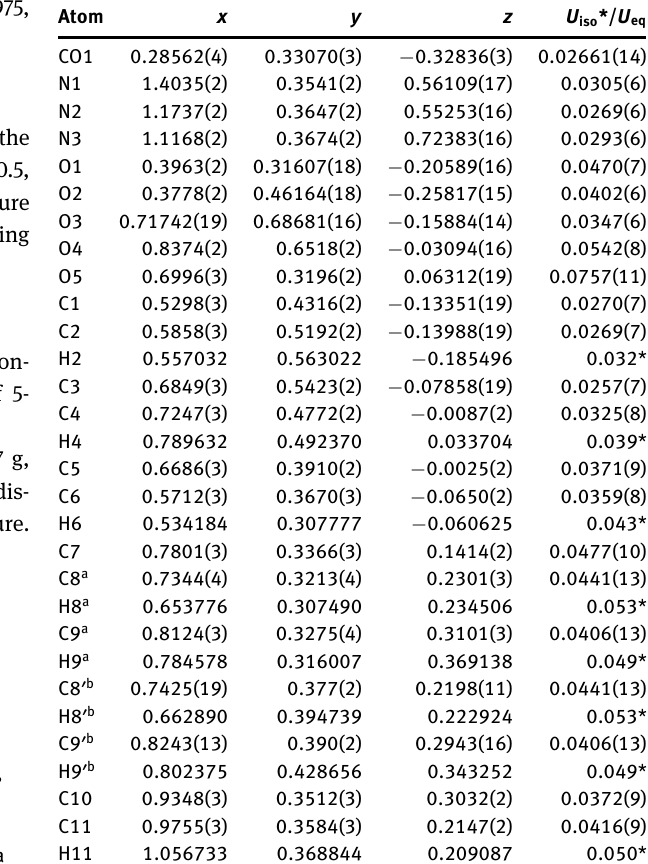
Table 2: Fractional atomic coordinates and isotropic or